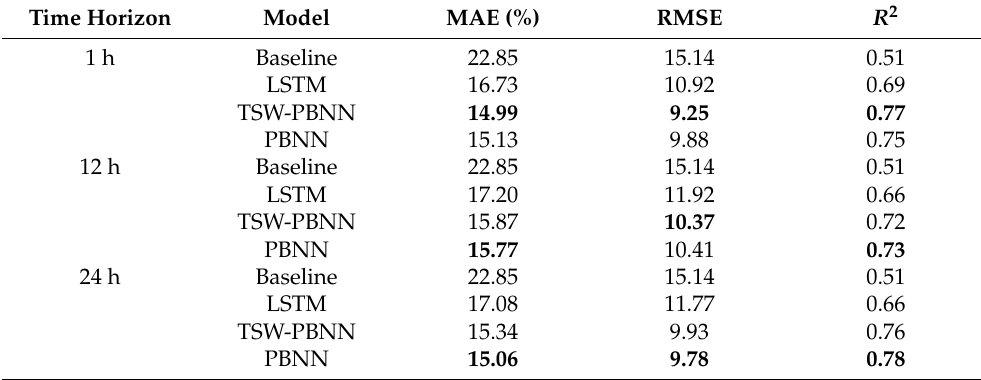
Table 8. Energy consumption prediction error of Building 164.